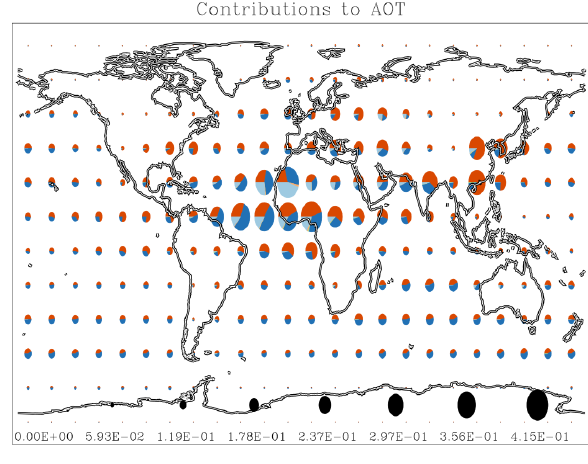
Figure 1. Definition of the regions that will be used for part of the analysis in this paper.